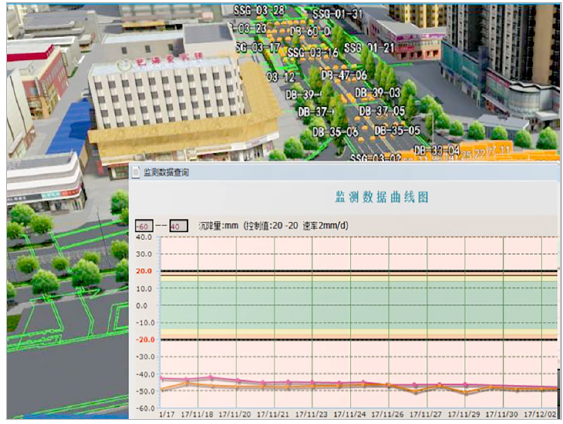
Figure 18. Generated monitoring data time history